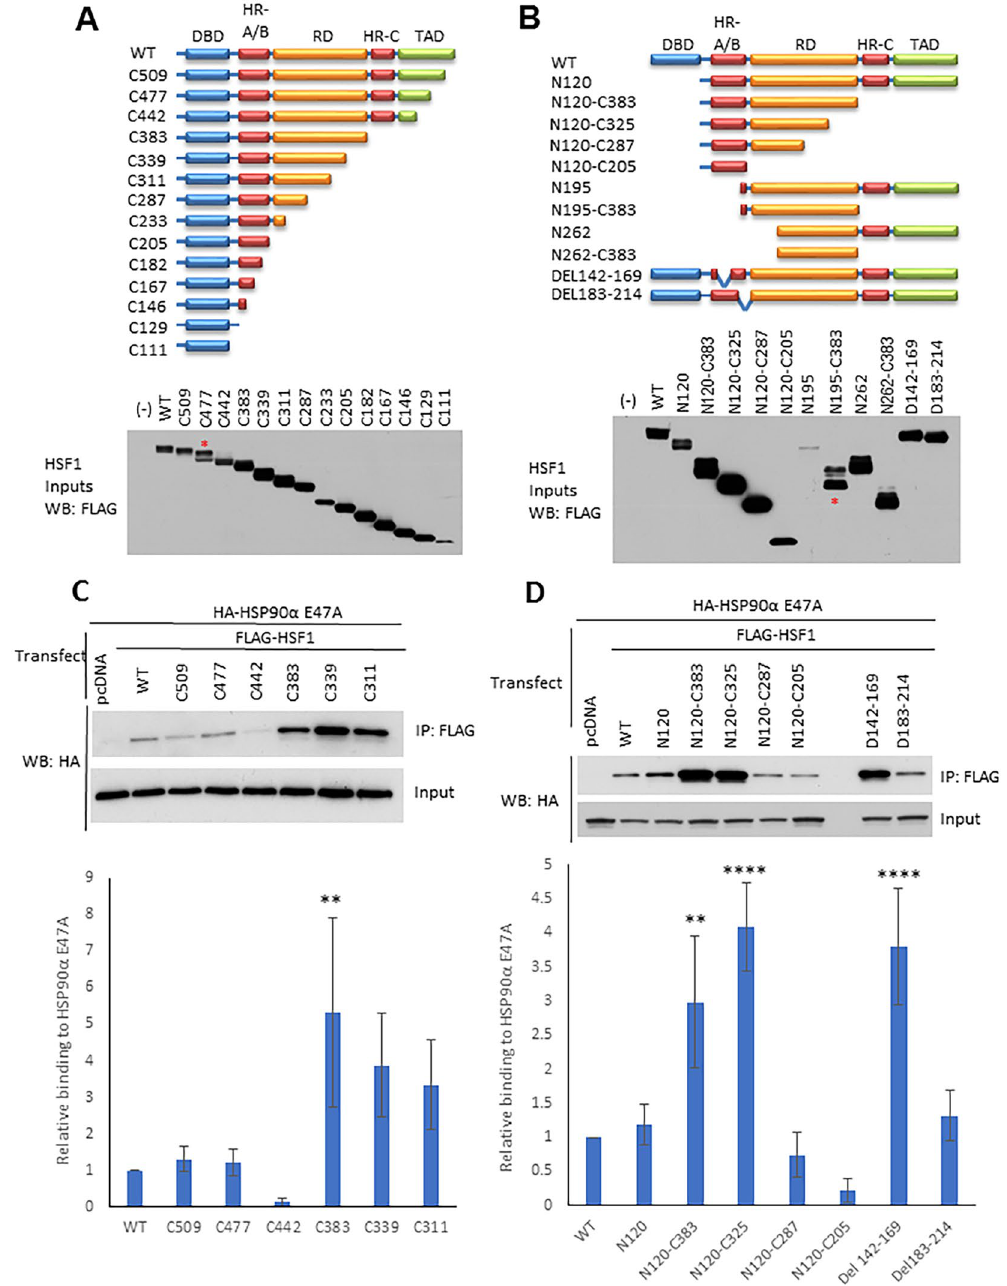
Figure 2. Mapping interaction sites of “closed” HSP90 on HSF1. ( A ) Schema of FLAG-HSF1 C-terminal truncation constructs and their expression in HEK293 cells. The associated blot shows expression of each construct in HEK293 cells. Equal amounts of DNA were used for transfection. For construct C477, the upper band represents the intact truncation (designated by an asterisk), while the lower band is likely a proteolytic fragment. ( B ) Schema of FLAG-HSF1 N-terminal truncation and internal deletion constructs and their expression in HEK293 cells. The associated blot shows expression of each construct in HEK293 cells. Equal amounts of DNA were used for each transfection. Note the poor expression of N195. For N195-C383, the lower band represents the intact construct (designated by an asterisk); the upper band may reflect a post translationally modified peptide. ( C ) Interaction of selected FLAG-HSF1 C-terminal truncation constructs with HA-tagged HSP90 α E47A. HEK293 cells were transfected with either FLAG-HSF1 constructs or FLAG-pcDNA control and HA-HSP90 α E47A, and then analyzed by anti-FLAG (HSF1) IP followed by HA (HSP90 α E47A) WB. Pull downs were performed in triplicate and western blots analyzed by densitometry. All HA IP bands were normalized to their respective FLAG IP signals (see Supplemental Figure 6, compilation of full blots) and then normalized to the WT signal. A one-way ANOVA utilizing multiple comparisons was performed to determine significant differences in HSP90 interaction between truncated HSF1 constructs and F-HSF1 WT. A representative blot is shown above the bar graph. Significance is indicated by asterisks ( **